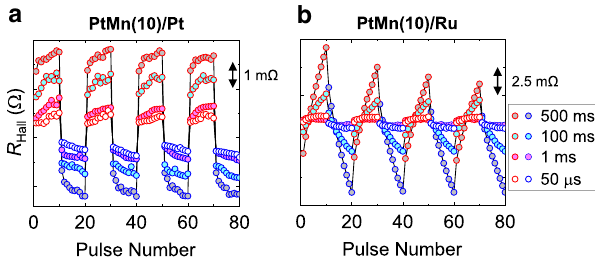
Fig. 2 Different characteristics of current-induced switching between PtMn/Pt and PtMn/Ru structures. ( a ) Pulse width ( τ P ) dependence of transverse Hall resistance ( R Hall ) for PtMn(10)/Pt under applied J Pt = 3.27 × 10 11 A m − 2 ( J PtMn = 8.17 × 10 10 A m − 2 ) for τ P = 50 µ s, 1, 100 and 500 ms. ( b ) Experimental results of τ P dependence of R Hall for PtMn(10)/ Ru structure for applied J PtMn = 2.62 × 10 11 A/m 2 with similar polarities of I 1 and I 2 . Red and blue-rimmed circles correspond to applied I 1 and I 2 , respectively. The polarities of I 1,2 are identical to that in Fig.